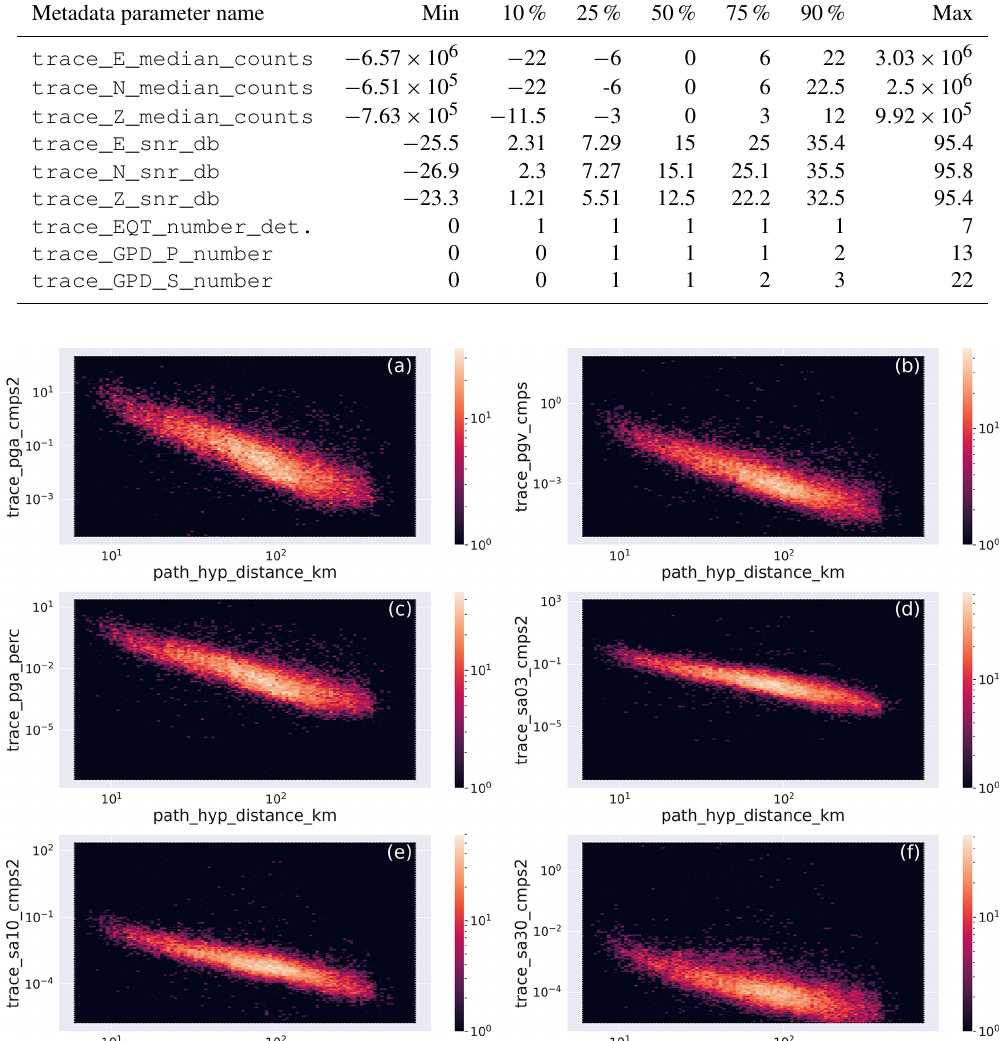
Table 3. Distribution according to different quantiles of selected metadata (cf. Table 2) for the HH channels of the event dataset.